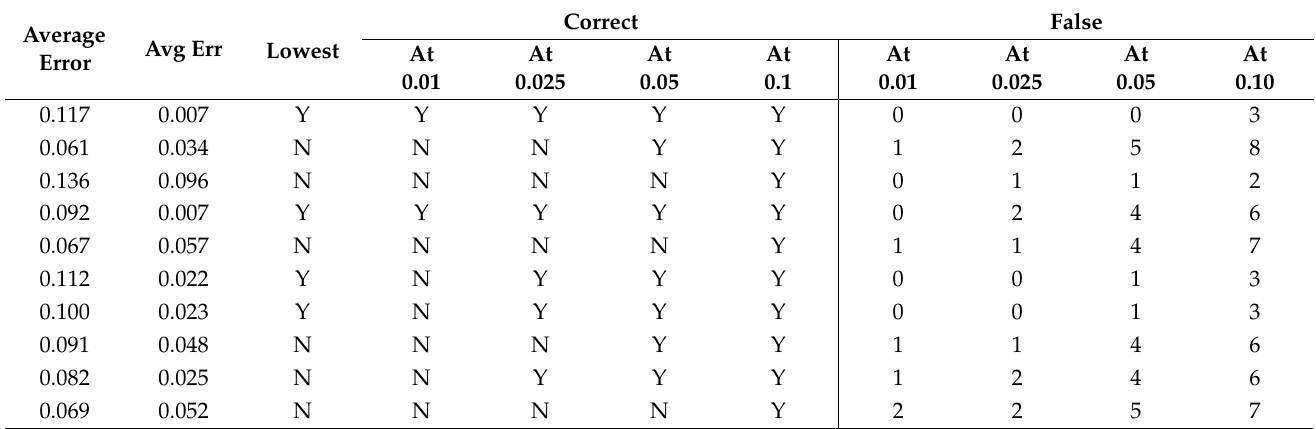
Table A169. Set 3, trials 1–10 summary data (actual PR value).